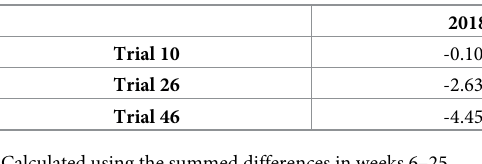
PLOS ONE | https://doi.org/10.1371/journal.pone.0271820 July 28,